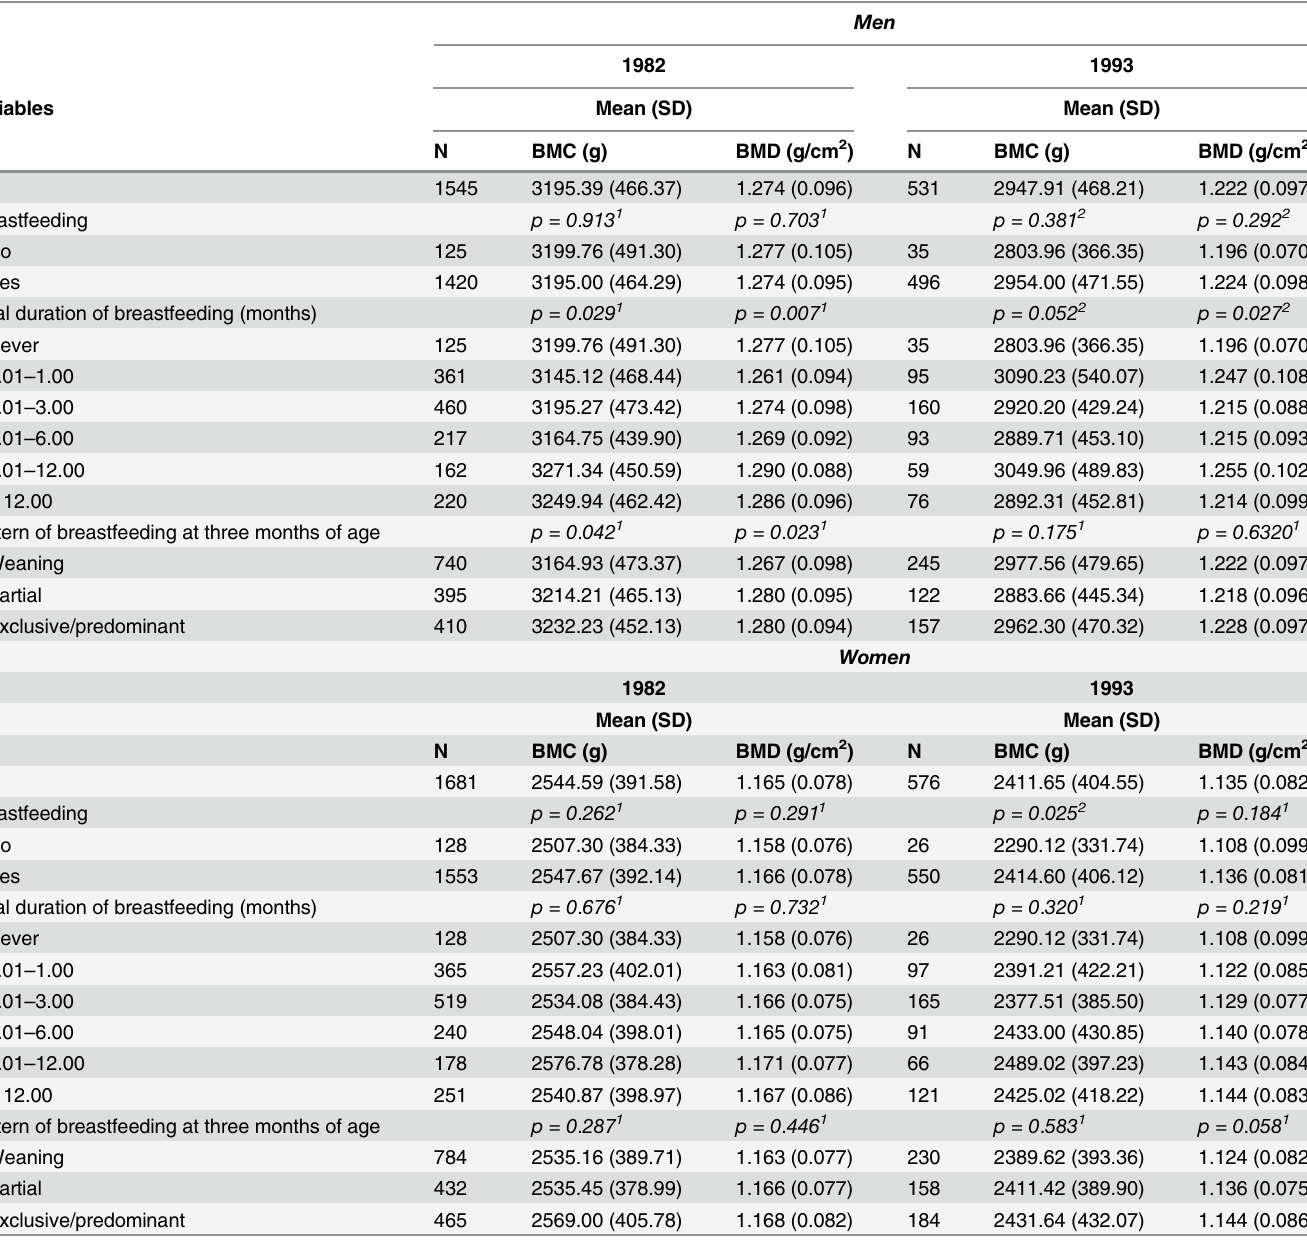
Table 2. Descriptive analysis of the whole body bone mineral content (BMC) and bone mineral density (BMD) at ages 18 and 30 according to breastfeeding variables, stratified by sex. The 1982 and 1993 Pelotas Birth Cohorts.